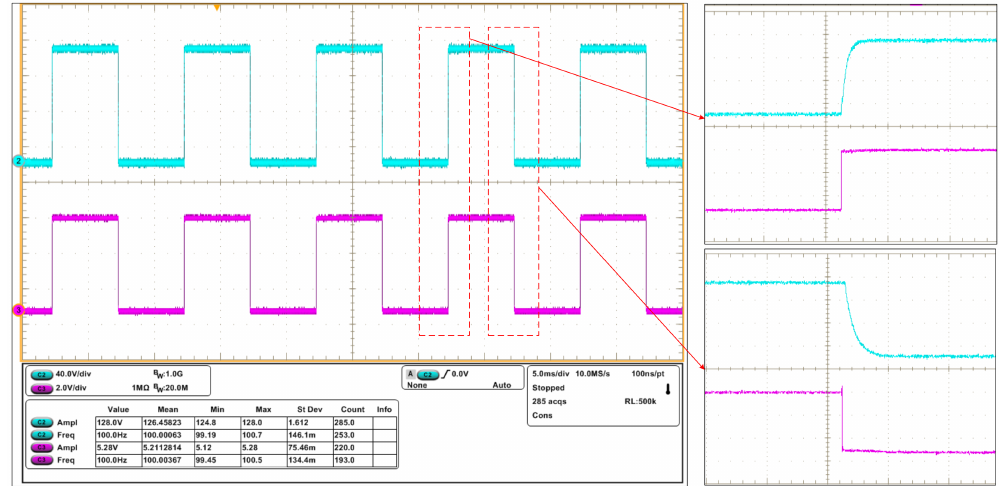
Figure 18. Measured square wave input–output waveforms for the power amplifier using high-voltage